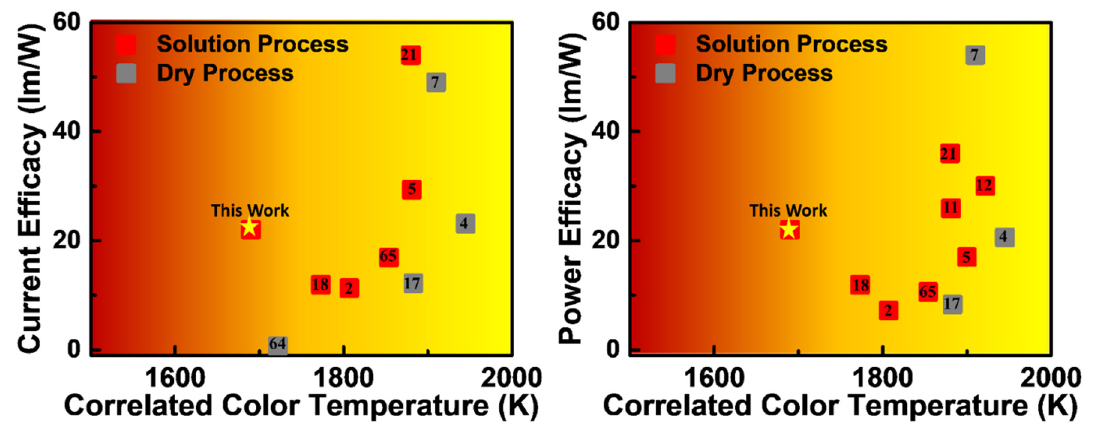
Figure 7. The reported color temperature (at 100 cd/m 2 ) for the solution and dry-processed candlelight organic LED devices against current efficacy and power efficacy [2,4,5,7,11,12,17,18,21,64,65].